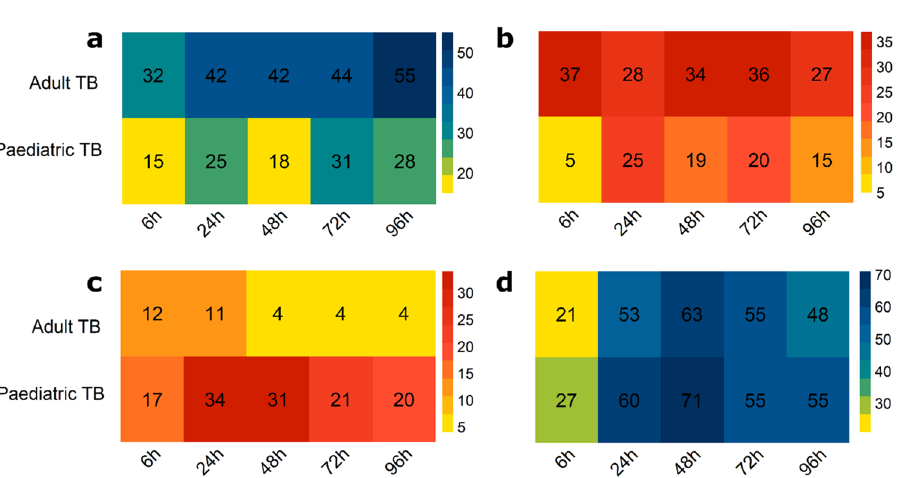
Figure 3. Counts of concordantly and discordantly regulated gene modules. Gene Set Enrichment Analysis (GSEA) was performed on transcripts from the four disco plot quadrants for each in vitro–in vivo comparison. Identified modules were counted and plotted as heatmaps in the same arrangement as quadrants of a discoplot from which the transcripts were taken. Colour intensity ranging from yellow to red for concordant modules, and yellow to blue for discordant modules, denotes increasing number of modules identified. ( a ) Counts of discordant modules, upregulated in vivo , and downregulated in vitro. ( b ) Counts of concordantly upregulated modules. ( c ) Counts of concordantly downregulated modules. ( d ) Counts of discordant modules, downregulated in vivo , and upregulated in